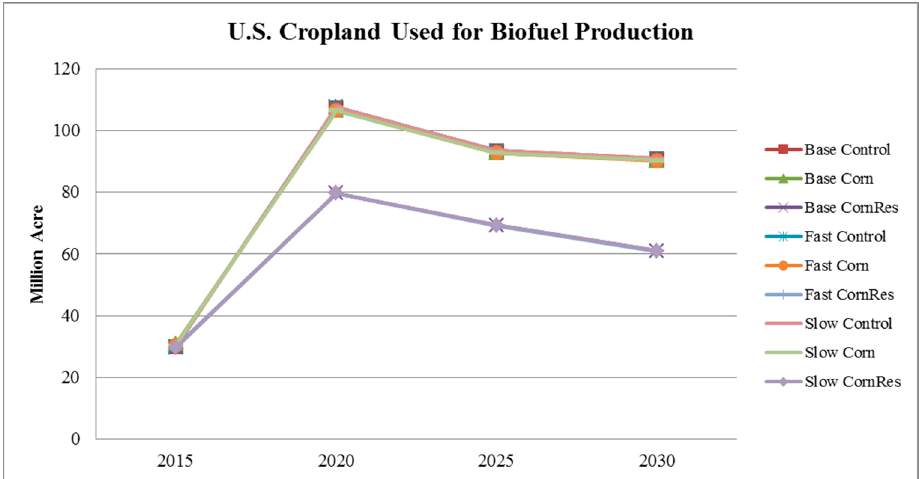
Figure 3. Average U.S. cropland for biofuel production projection during 2015 to 2030.